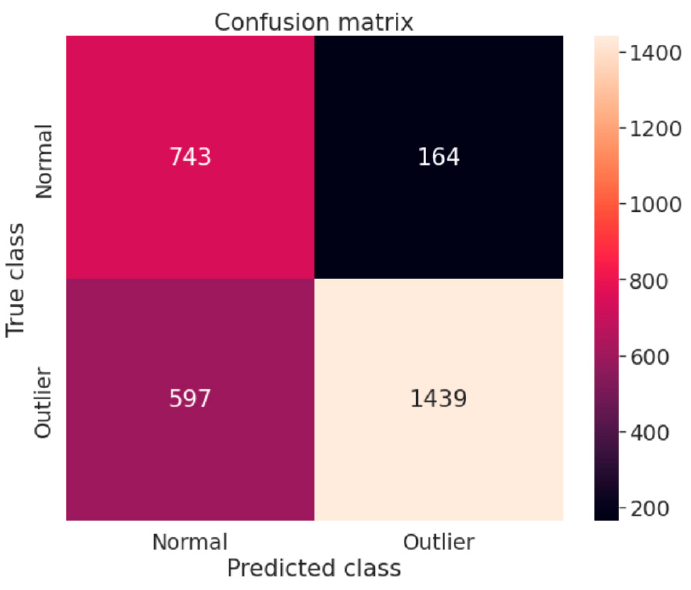
Figure 6. Confusion matrix with Statlog (Landsat Satellite) dataset.